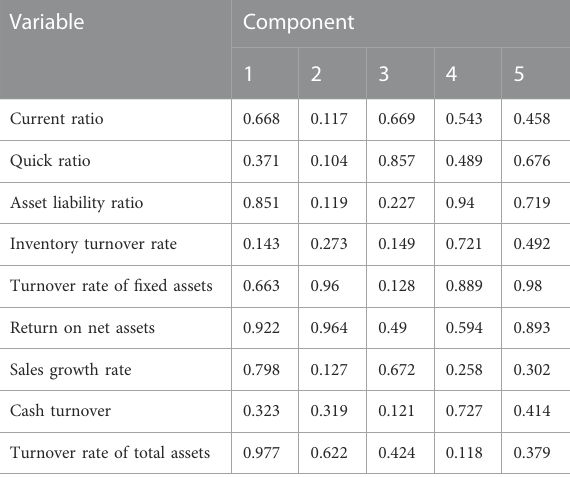
TABLE 2 Rotated composition